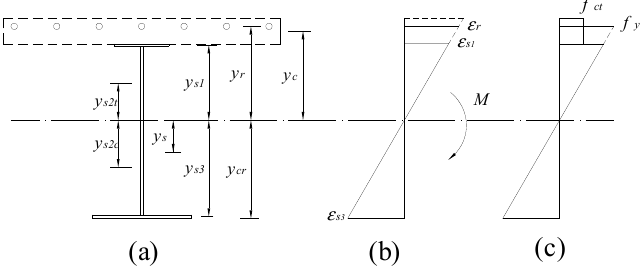
Figure 16. Calculation diagram: ( a ) crack section; ( b ) strain distribution; ( c ) stress distribution.